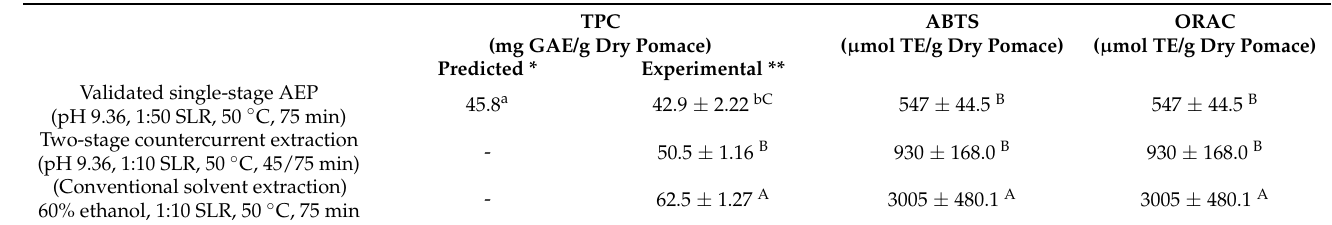
Table 2. TPC and antioxidant activities of validated single-stage AEP, two-stage countercurrent AEP, and conventional solvent